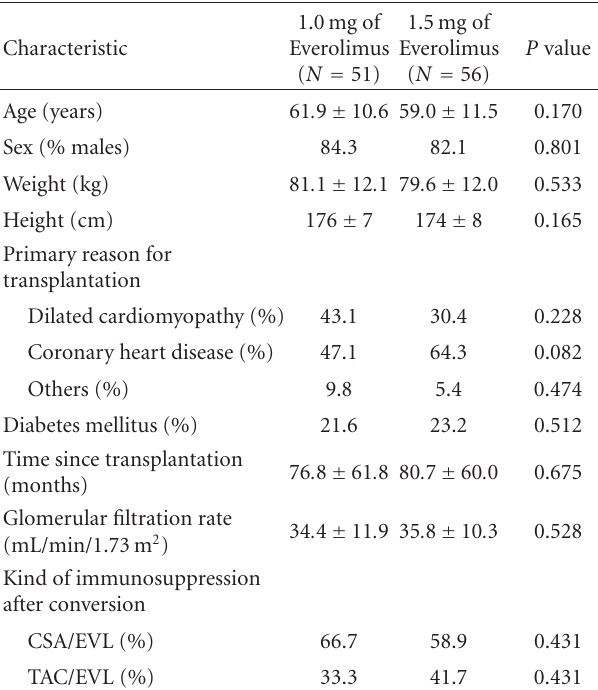
Table 1: Characteristics of the